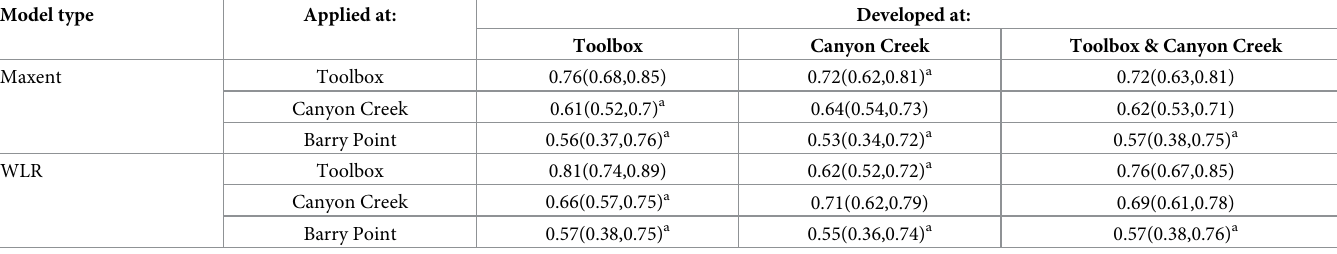
Table 7. AUC scores (with bootstrapped 95% CIs) indicating discrimination accuracy of nest from non-nest sites for white-headed woodpecker in burned forest. Models were developed at Toolbox and Canyon Creek wildfire locations, and evaluated at both development locations and the Barry Point location. Maxent models were developed with remotely sensed data, and weighted logistic regression models with both remotely sensed and field collected data. AUCs with 95% CIs overlapping 0.5 indi- cated poor discrimination accuracy.